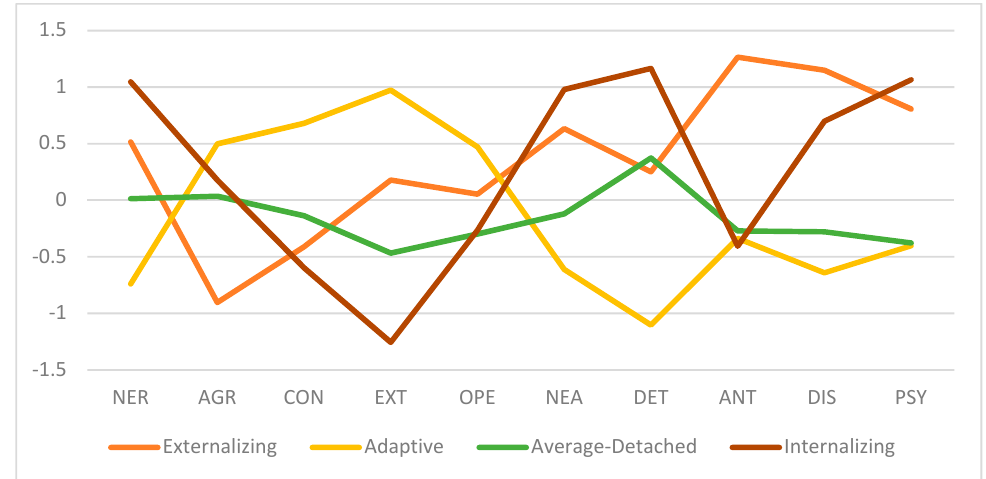
Figure 3. Profile plot for Five Factors for FFM–AMPD Combined Profiles. Note. Standardized mean Figure 3. Pro fi le plot for Five Factors for FFM–AMPD Combined Pro fi les. Note. Standardized mean scores (M = 0, SD = scores (M = 0, SD = 1) of the Five Factor Model of Normative Personality and Alternative Model of 1) of the Five Factor Model of Normative Personality and Alternative Model of Personality across four pro fi les. Personality across four